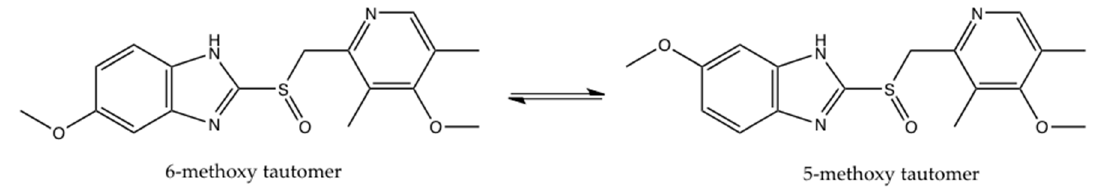
Figure 1. The 5-methoxy and 6-methoxy tautomers of omeprazole.